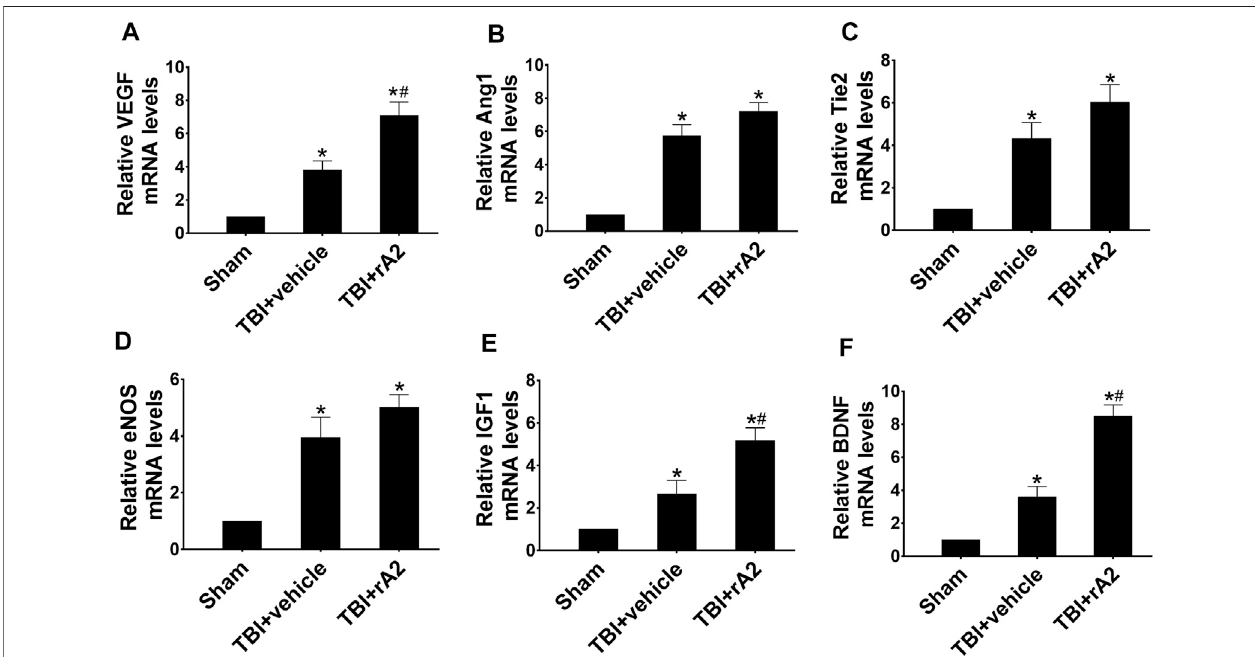
FIGURE2| rA2 administration augmentsmRNAlevels ofpro-angiogenic factors inthe isolated cerebral microvascularfragmentsat 7 days after TBIinmice. Gene expression levels of pro-angiogenic factors in the brain microvesselswere measured at 7 days after TBI by RT-qPCR. Quantitative analysis ofmRNA levels ofVEGF (A) , Ang1 (B) ,Tie2 (C) ,eNOS (D) ,IGF1 (E) , and BDNF (F) . Dataareexpressed asmean ± SEM; n (cid:1) 4miceper group, * p < 0.05comparedtoSham, # p < 0.05 compared to TBI+vehicle (1 mg/kg